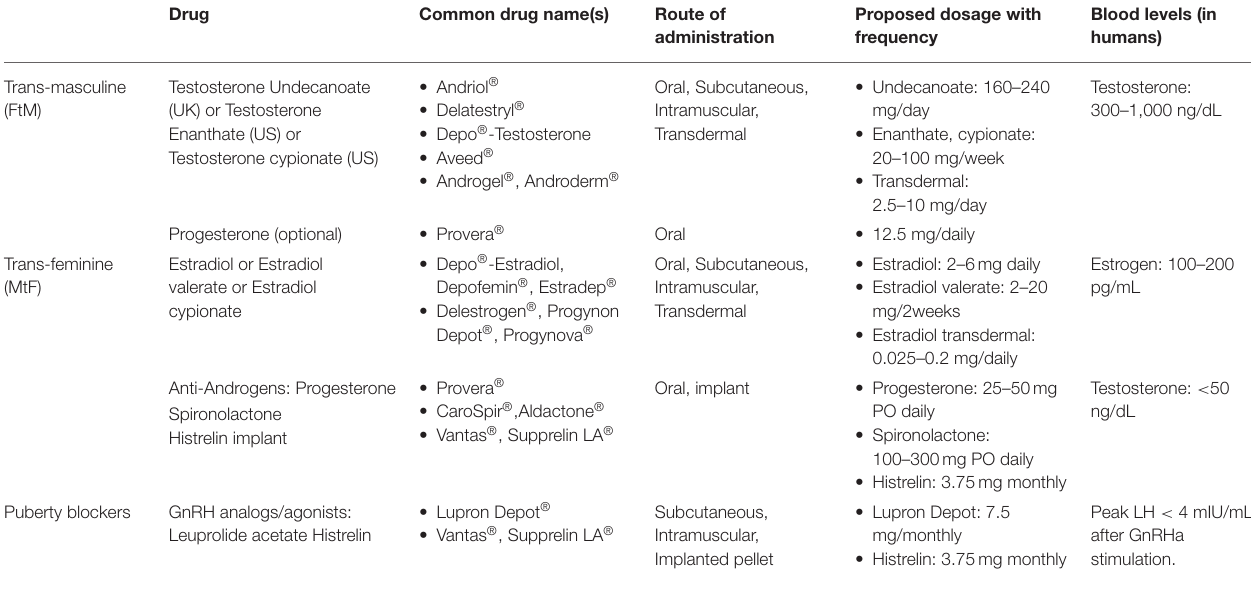
TABLE 1 | Drugs used for gender affirming hormonal treatments in TGNC